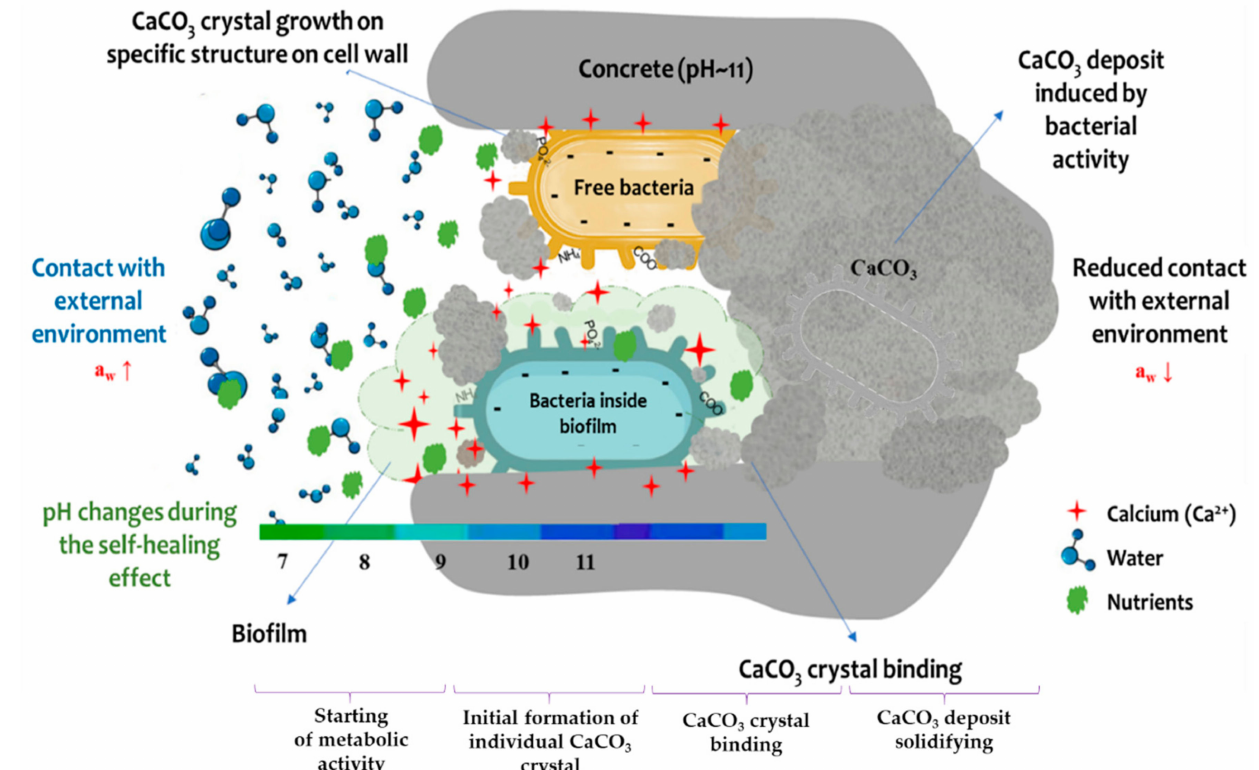
Figure 4. Bacterial behaviour in